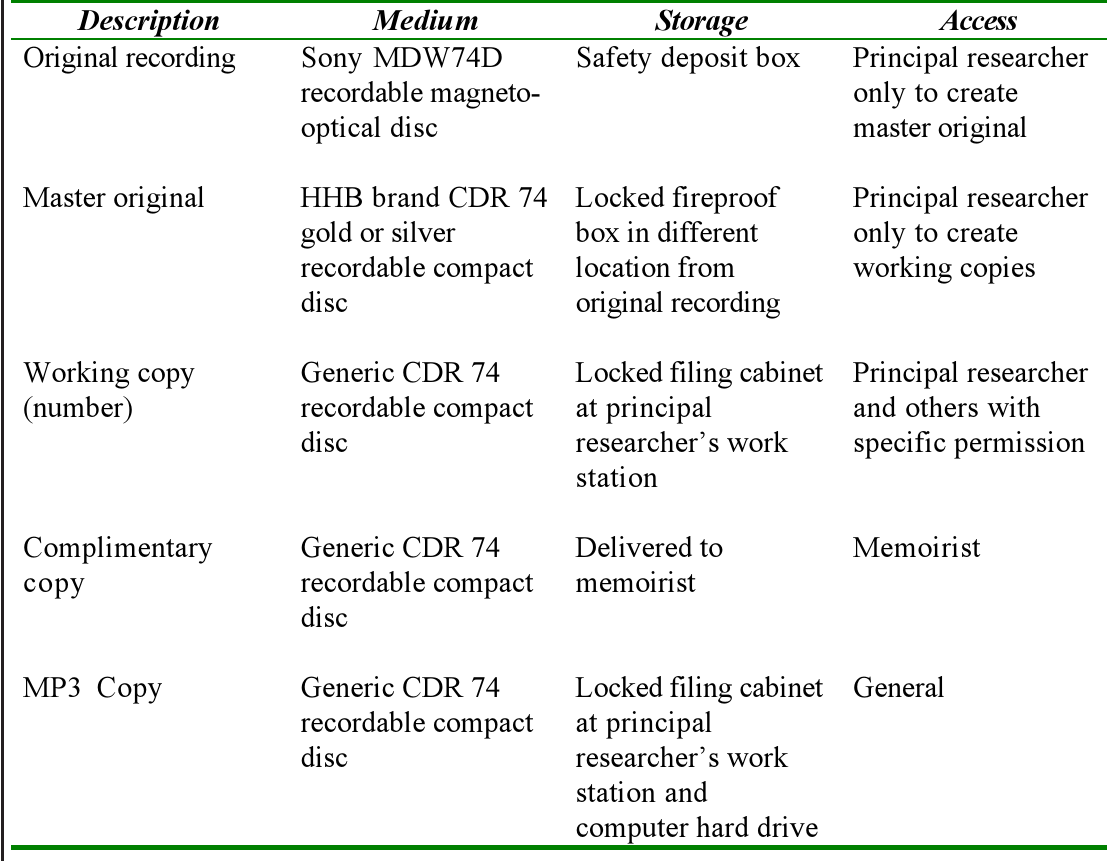
Table 1. Summary of Storage and Access to Recordings